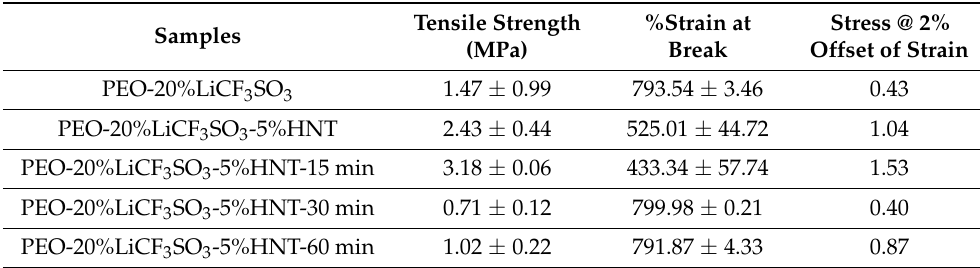
Figure 11. Stress–strain curves of solid polymer electrolytes at room temperature. Table 4. Tensile properties of SPEs.